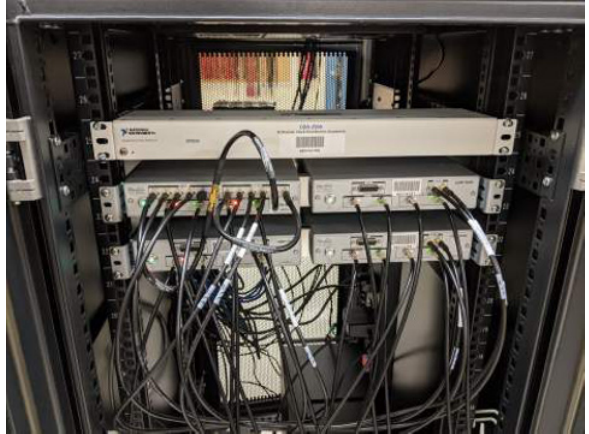
Figure 7. Four Ettus Research SDRs and a Clock Destitution Unit of the MIMO Radar